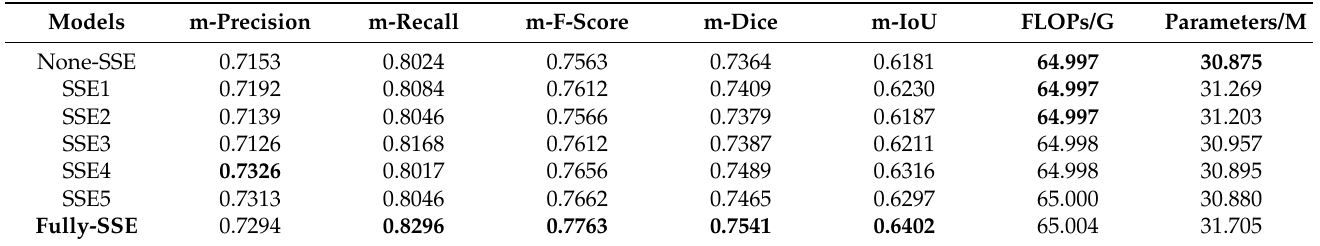
Table 3. Results of different SSE modules. The best average scores are in bold.